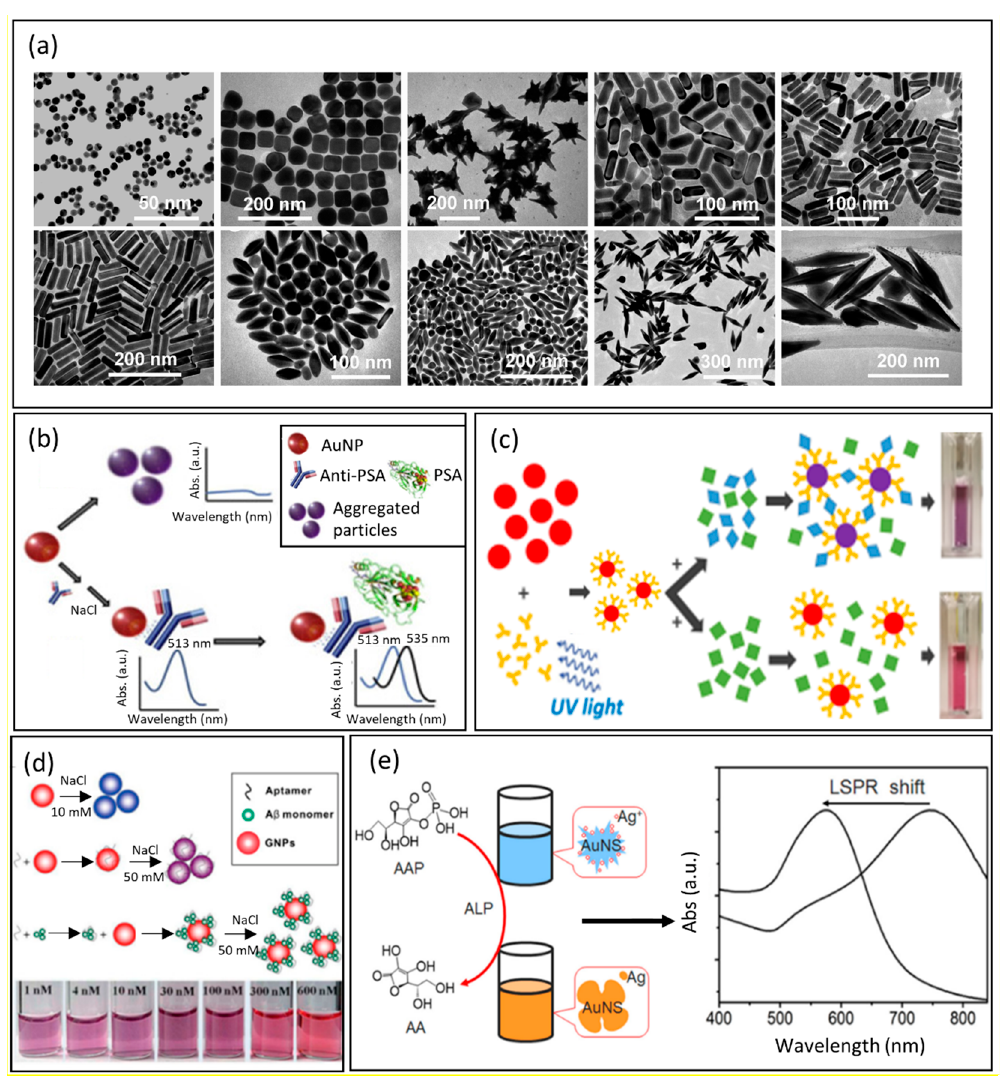
Figure 1. ( a ) From left to right, representative TEM images of Au nanoparticles of different shapes: on the top, nanospheres, nanocubes, nanobranches, nanorods (aspect ratio = 2.4 ± 0.3), and nanorods (aspect ratio = 3.4 ± 0.5); on the bottom, nanorods (aspect ratio = 4.6 ± 0.8), nanobipyramids (aspect ratio = 1.5 ± 0.3), nanobipyramids (aspect ratio = 2.7 ± 0.2), nanobipyramids (aspect ratio = 3.9 ± 0.2), and nanobipyramids (aspect ratio = 4.7 ± 0.2). Reproduced Adapted with permission from Ref. [48]. Copyright (2008), American Chemical Society. ( b ) Representation of the mechanism of the optical nanosensor for the detection of PSA. Colloidal AuNPs change color from red to purple in the absence of antibody proteins. The conjugation of antibodies to AuNPs stabilizes them and enables the detection of PSA. Adapted with permission from Ref. [50]. Copyright (2021), Elsevier. ( c )